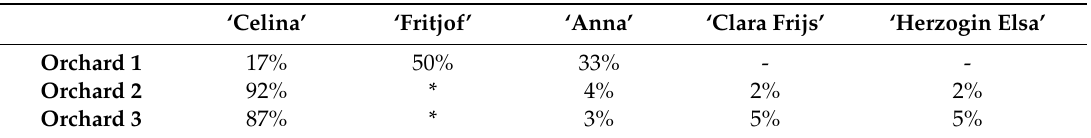
Table 1. Pear cultivar compositions and the abundance of each cultivar within the three orchards sampled in this study. ‘Celina’ ‘Fritjof’ ‘Anna’ ‘Clara